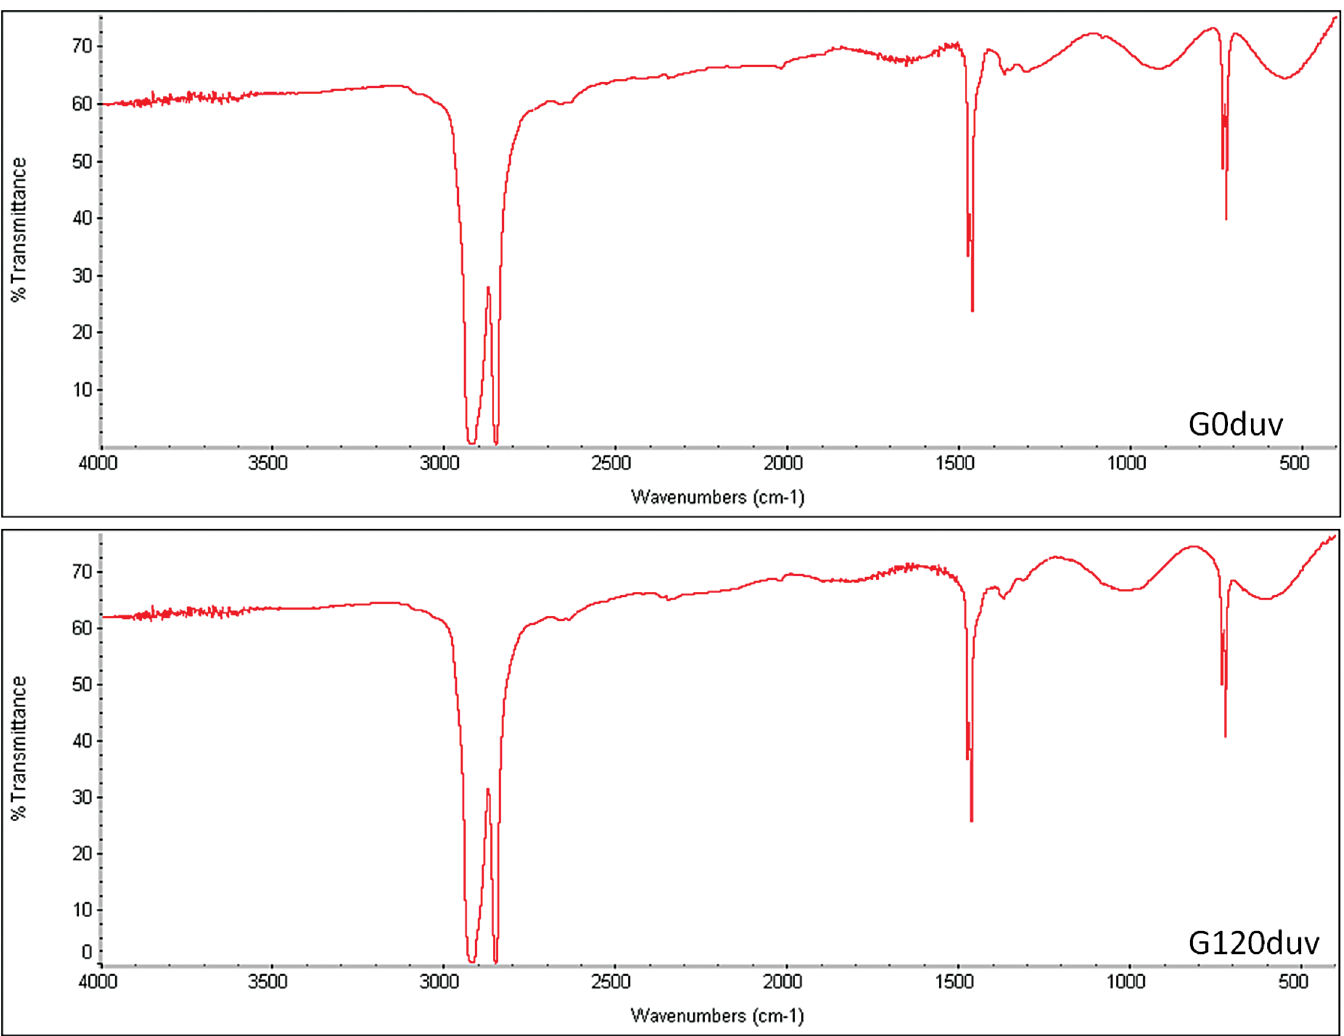
Fig 1. FTIR spectrum of the green polyethylene before (G0duv) and after 120 d of exposure to sunlight (G120duv). The bands: 3000 – 2500 cm -1 – Bond carbon-hydrogen (CH 2 or CH 3 ); 1500 – 1400 cm -1 — Bond carbon-hydrogen (CH) and 800 – 700 cm -1 — Bond carbon-carbon